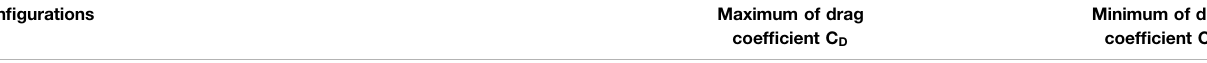
TABLE 3 | Comparison between maximum and minimum values of drag and lift coef fi cients for various con fi gurations. Con fi